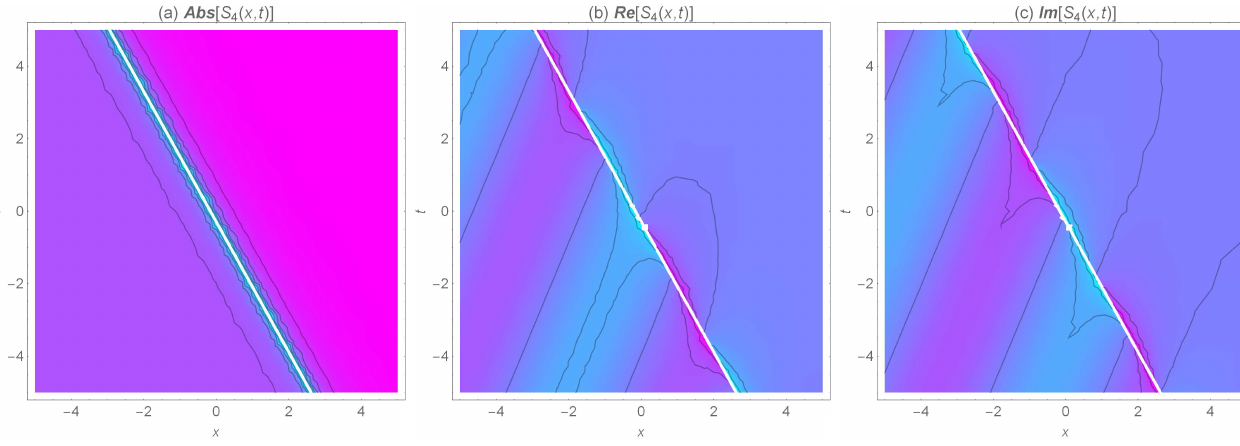
Figure 6. The 2D density of the wave surfaces for the absolute, real, and imaginary values of the singular kink soliton solution for b = 0.9, c = − 0.3, s = 1.5, k = 1, ϑ 0 = 0.2, ε 1 = 1, ε 2 = 1, ε 3 = 1.2, Ω =